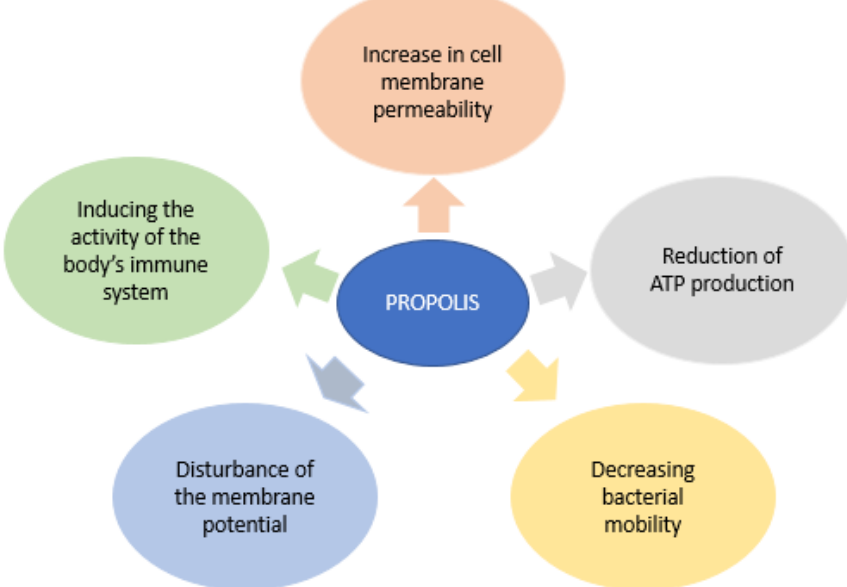
Figure 5. Antibacterial activity of propolis. Reprinted from [52].